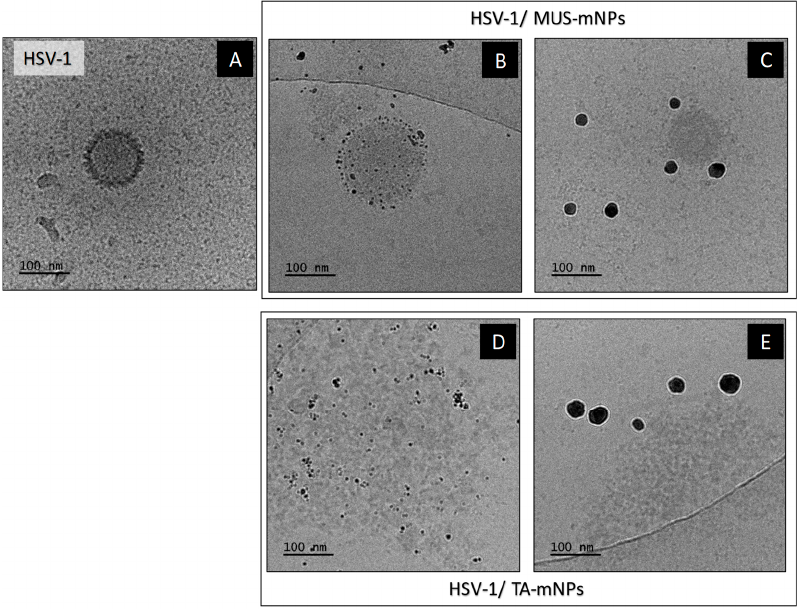
Figure 5. cryo-TEM images of unstained samples: HSV-1 virus ( A ), HSV-1 virus after incubation with: 5MUS_5nmAgNPs ( B ), 5MUS_30nmAgNPs ( C ) TA_5nmAgNPs ( D ), TA_30nmAgNPs ( E ) (samples imaged after about 30 s of incubation of virus with functional nanoparticles). The Figure 5A presents the structure of untreated virus HSV-1. The analysis of the cryo-TEM images of sulfonate-NPs (Figure 5B,C) and TA-NPs (Figure 5D,E) revealed the differences in the number of nanoparticles in the vicinity of the virus for different nano- conjugates (Figure 5). In the case of sulfonate-functionalized nanoparticles, viruses imme- diately associate particles. The virus structure is covered with nanoparticles which can be easily seen in Figure 5B for 5MUS_5nmAgNPs. The high virus affinity to sulfonated na- noparticles can also be seen for nanoparticles with a size equal to 30 nm (5MUS_30nmAgNPs–Figure 5C). However, the analysis of the cryo-TEM images revealed that the sulfonated functional nanoparticles do not damage the envelope of viruses. The large number of nanoparticles adsorbed on the virus surface proves that they show a high affinity for its surface, and their mechanism of action is mainly based on the physical blocking of the interaction of the virus with host cell. In the case of tannic acid functional nanoparticles, the virus structure and the capsid are damaged (Figure 5D,E), eliciting the release of viral genetic materials leading to its destruction and virus inactivation. A lot of nanoparticles can also be visible in the vicinity of the damaged virus structures, indicating the virus’s high affinity to TA-mNPs and the high virucidal activity of functionalized na- noparticles. Those results suggest that the sulfonated-functional nanoparticles act rather virustatic, which is in agreement with Stellacci and co-workers’ [26] results, which re- ported heparan sulfate proteoglycans-mimicking materials effect as simply virustatic. At the same time, the tannic acid-functionalized nanoparticles exhibit a very strong virudical effect that causes irreversible viral deactivation by its degradation while maintaining low- toxic (Table S1 Supplementary Materials). 3. Discussion The transmission of HSV virus occurs mainly by direct contact. The HSV infection disease begins with the adhesion of viral glycoproteins to the host cell membrane. The